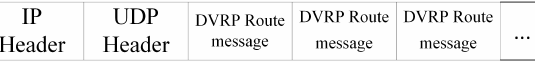
Figure 3: Neighbor Table